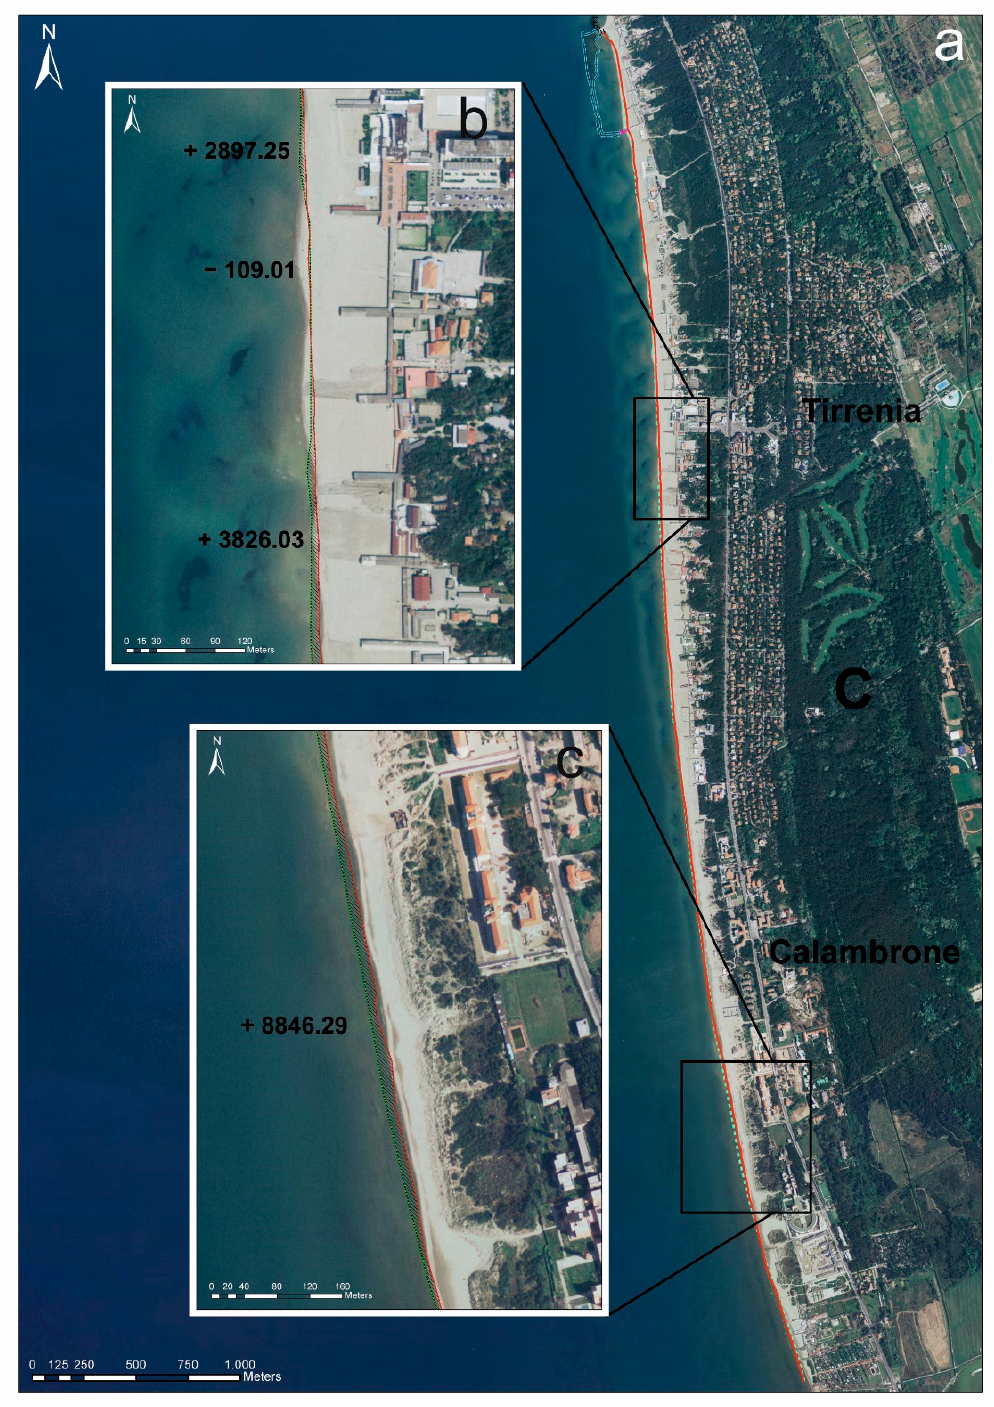
Figure 9. ( a ) Coastline monitoring in the area C, 23 days after the event of 3 February 2019. Red line DGPS measurements acquired on 1 October 2018, and yellow line DGPS measurements acquired on 26 February 2019. The numbers in ( b , c ) represent the areal changes (in m 2 ) between the two acquisitions.